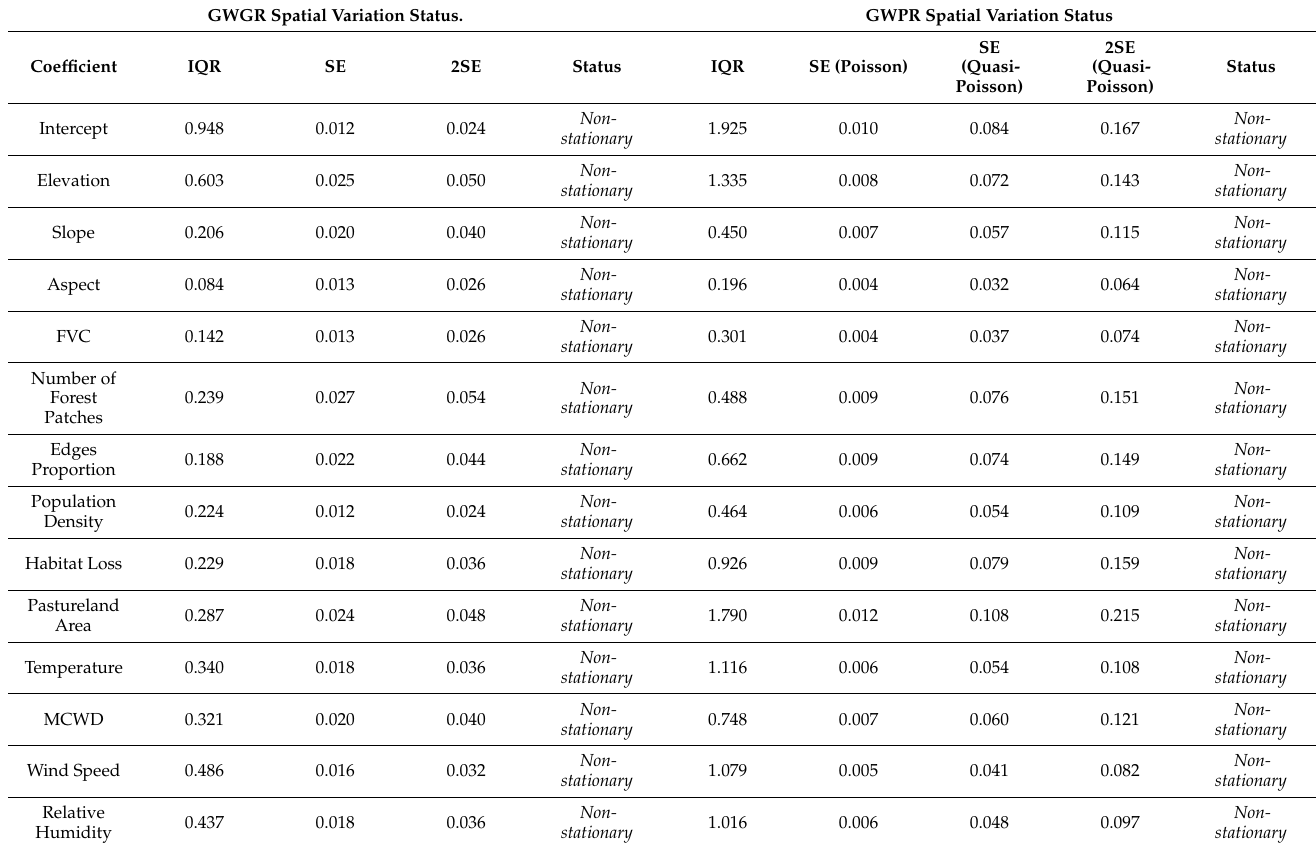
Table 4. Summary statistics for estimated local coefficients from the OLS and Poisson model and relative spatial variation